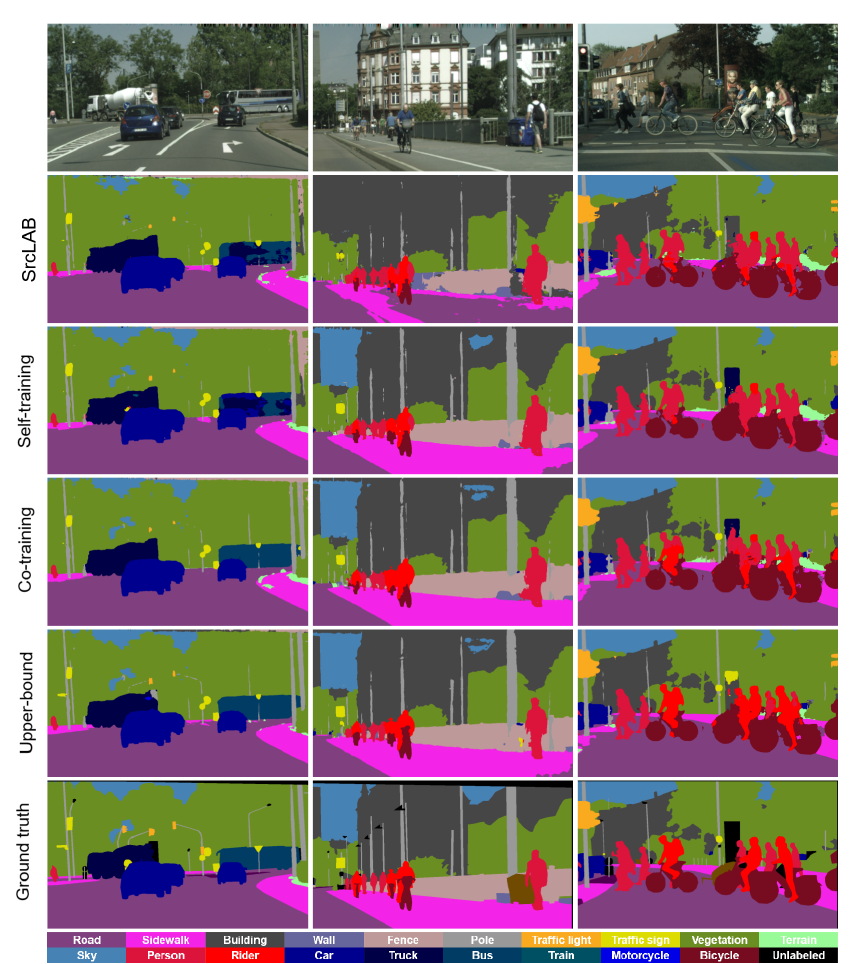
Figure A4. Qualitative results on the validation set of Cityscapes when relying on GTAV + Syn- scapes as source data. The baseline model is trained using only these source data, the upper-bound model uses these source data and all the labeled training data of Cityscapes. Self-training and co- training models rely on the source data and the same training data from Cityscapes but without the labeling